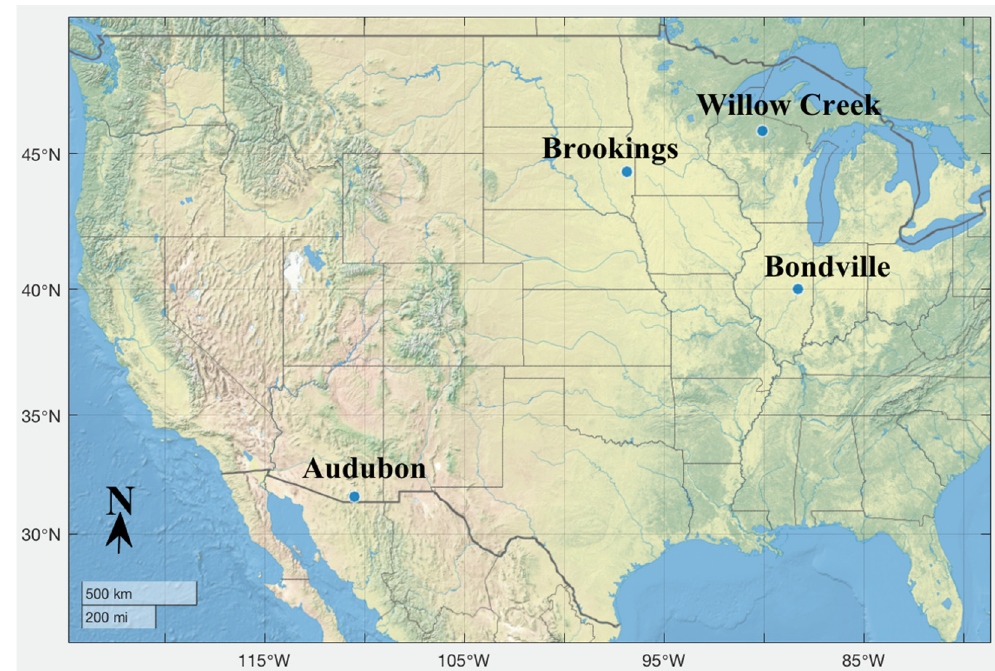
Figure 2. Locations of the four study sites (i.e., Audubon, Brookings, Bondville, and Willow Creek) in the United States.